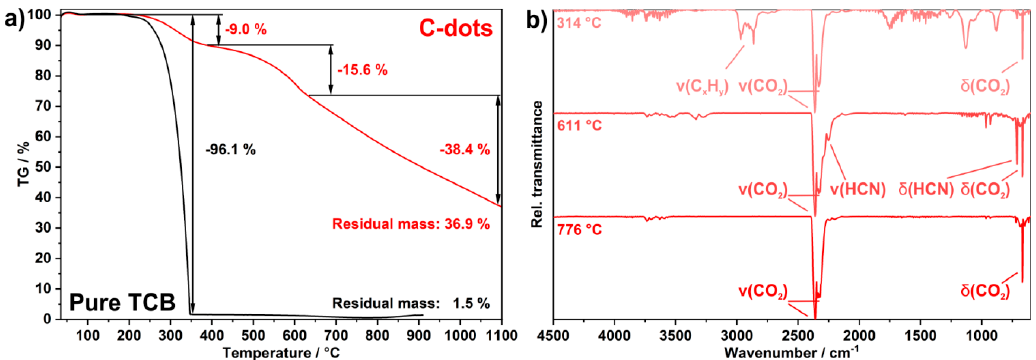
Figure 4. Thermal decomposition of the as-prepared C-dots: ( a ) thermogravimetry (nitrogen atmosphere, 27.7 mg of sample) with pure TCB as a reference (nitrogen atmosphere, 29.6 mg of sample); ( b ) Fourier-transform infrared spectra of the gaseous decomposition products of the thermogravimetric analysis at three selected temperatures. Figure 3. Chemical composition of the as-prepared C-dots: ( a ) X-ray diffraction pattern with pure TCB (starting material) and graphite (ICDD-No. 00-056-0159) as references; ( b ) Fourier-transform infrared spectra with pure TCB and pure PEG400 as references.